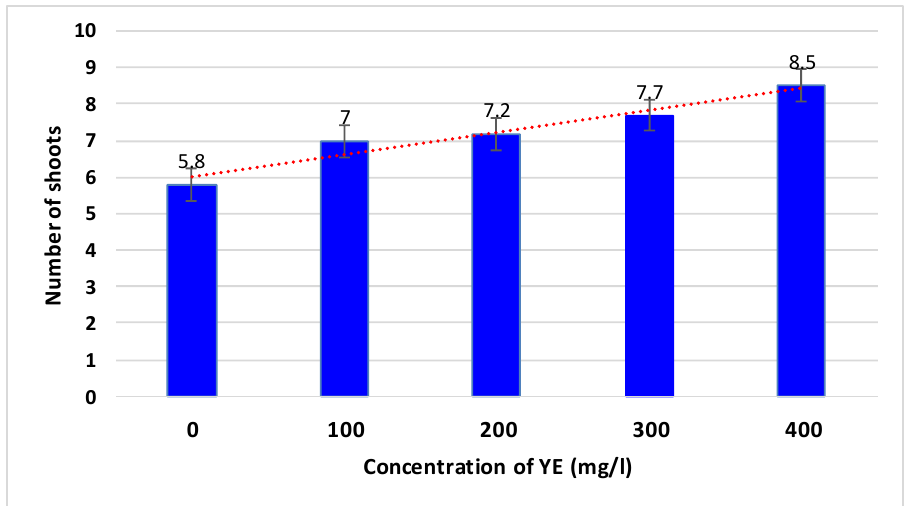
Figure 2b. Shoot multiplication in in vitro shoots of C. nutans in different concentrations of yeast